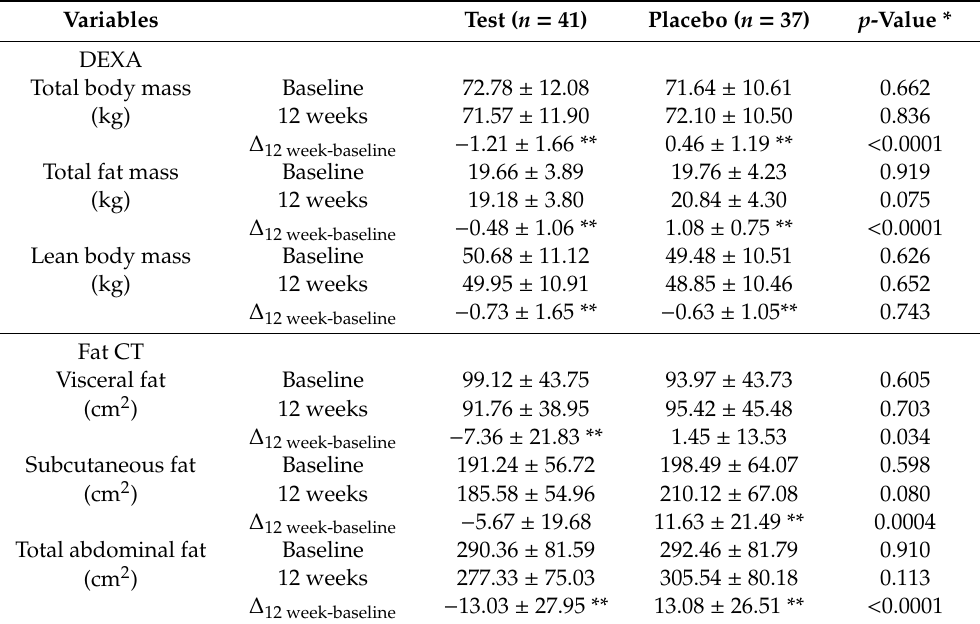
Table 4. E ff ect of Gelidium elegans on body